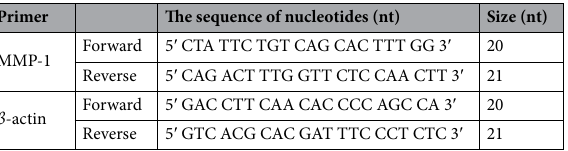
Measurement of oxidative stress biomarkers. The concentration of MDA and SOD (Biodiagnostic, Diag- nostic and research reagents, Egypt) were determined in the tissue lysate colorimetrically by a UV/Visible spectrophotometer(Schimadzu spectrophotometer 2401 UV/Visible, Japan) 55,56 . Measurement of Cyclooxygenase 2, Prostaglandin E2, collagen and elastin by ELISA. The concentrations of cyclooxygenase 2, prostaglandin E2, collagen, and elastin in the tissue lysate were determined using commer- cially available ELISA kits (Cyclooxygenase 2, ELISA Kit (MBS020842), MyBioSource, USA; Prostaglandin E2, ELISA kit, (CSB-E07966m), CUSABIO, USA; and Elastin ELISA Kit (E-EL-R0004), Elabscience, USA according to the manufacturer’s instructions.